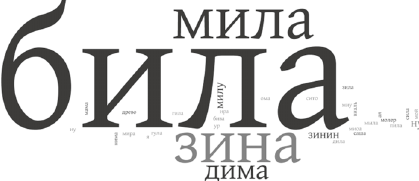
Figure 6: «Word cloud» for phonogram « 3KS1 »: native German speakers at signal-to-noise ratios = −9 and − 12dB [Base: 𝑛 = 107 ].